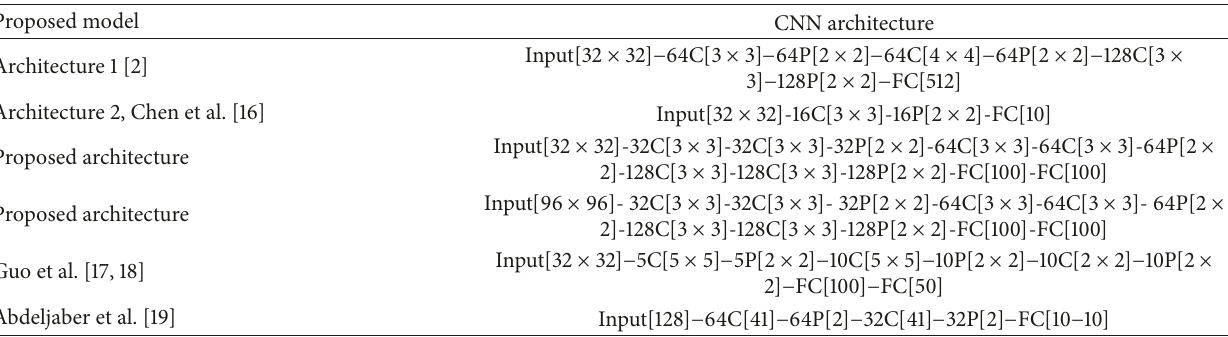
Table 1: Overview of CNN architectures used for fault diagnosis.